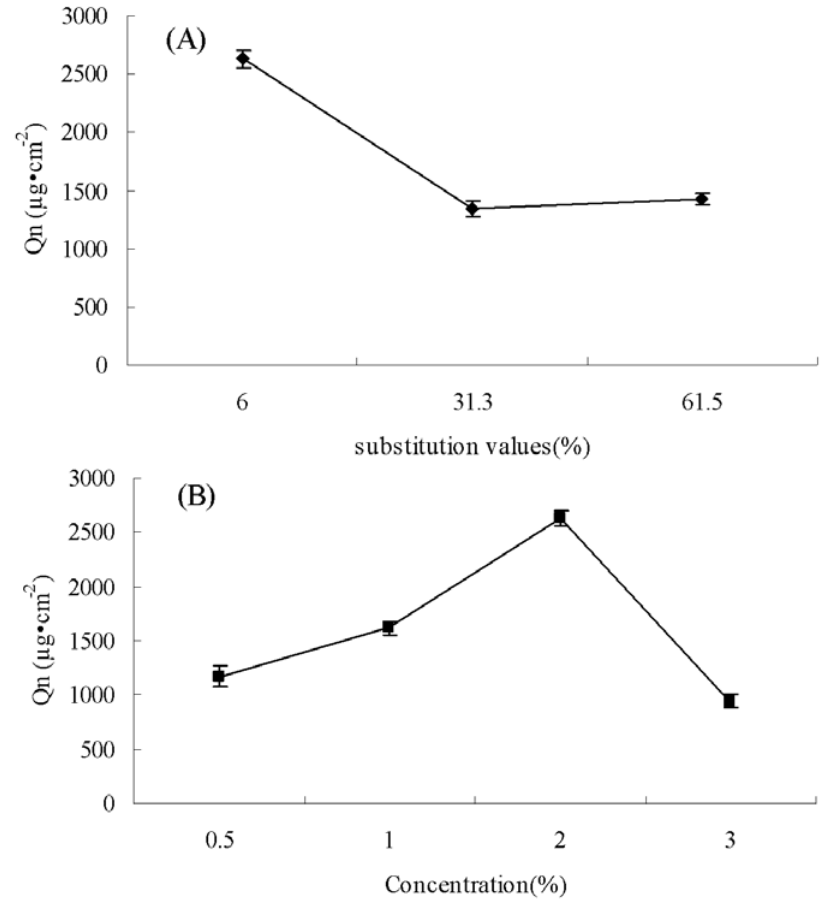
Figure 3. Effect of N- Arg-CS with different substitution values ( A ) and concentrations ( B ) on the skin penetration of adefovir after 12 h (n = 6) (A: The samples are N- Arg-CS-B, N- Arg-CS-D and N- Arg-CS-E and the concentration is 2%; B: The sample is N-